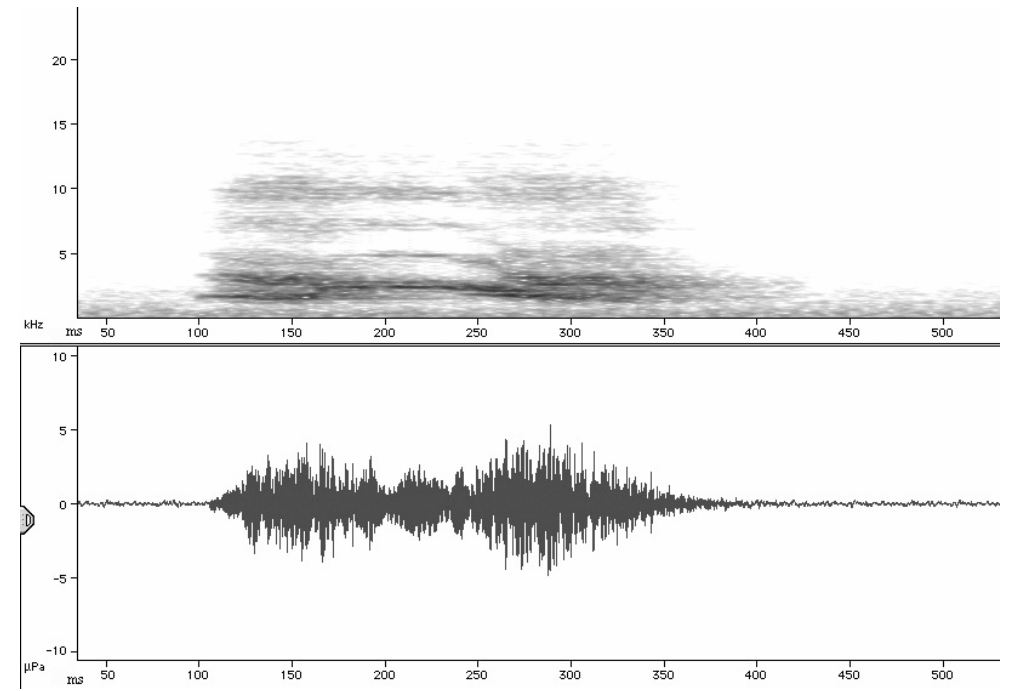
Fig. 1 – Spectrogram of father monosyllabic theme α